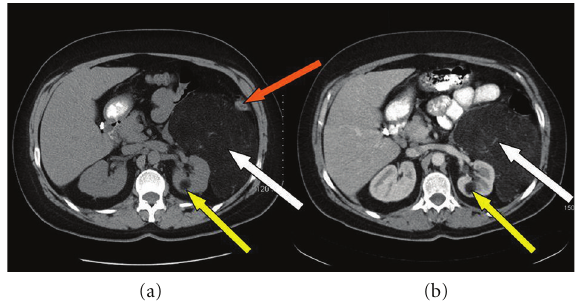
Figure 1: (a) oral contrast and (b) IV and oral contrast: abdominal computerized tomography demonstrating an encapsulated fatty vascular mass (white arrows) lateral to the left kidney measuring 19.3cm × 13.5 cm × 10.7 cm with prominent vascular dependence on the left renal vein and artery as well as a 2cm posterior mid-pole homogeneous fatty density (yellow arrow). Left colon is laterally displaced (orange